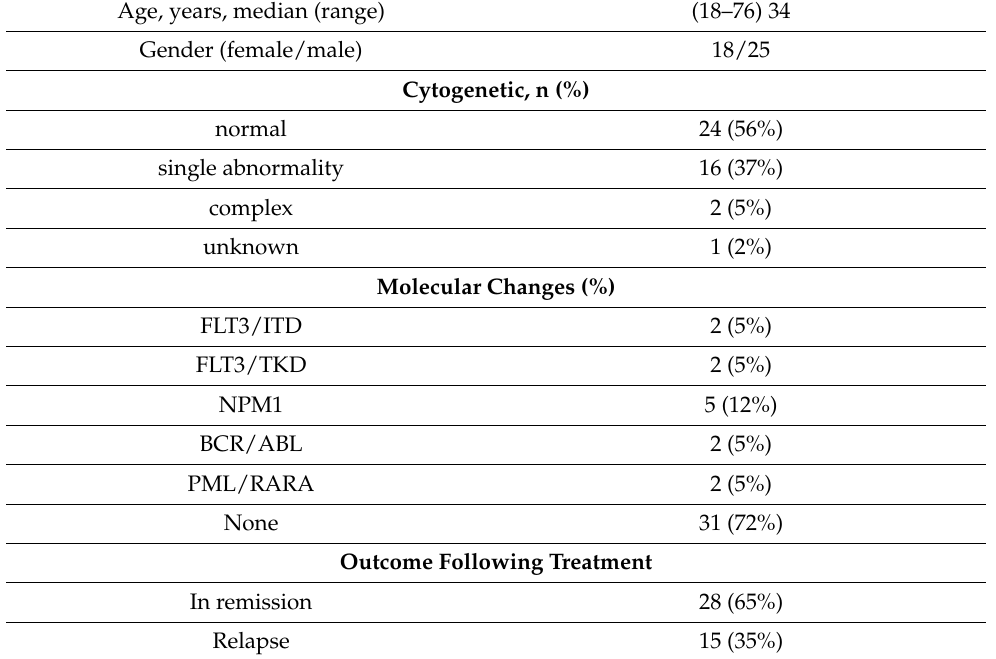
Table 1. Clinical information of AML patients.